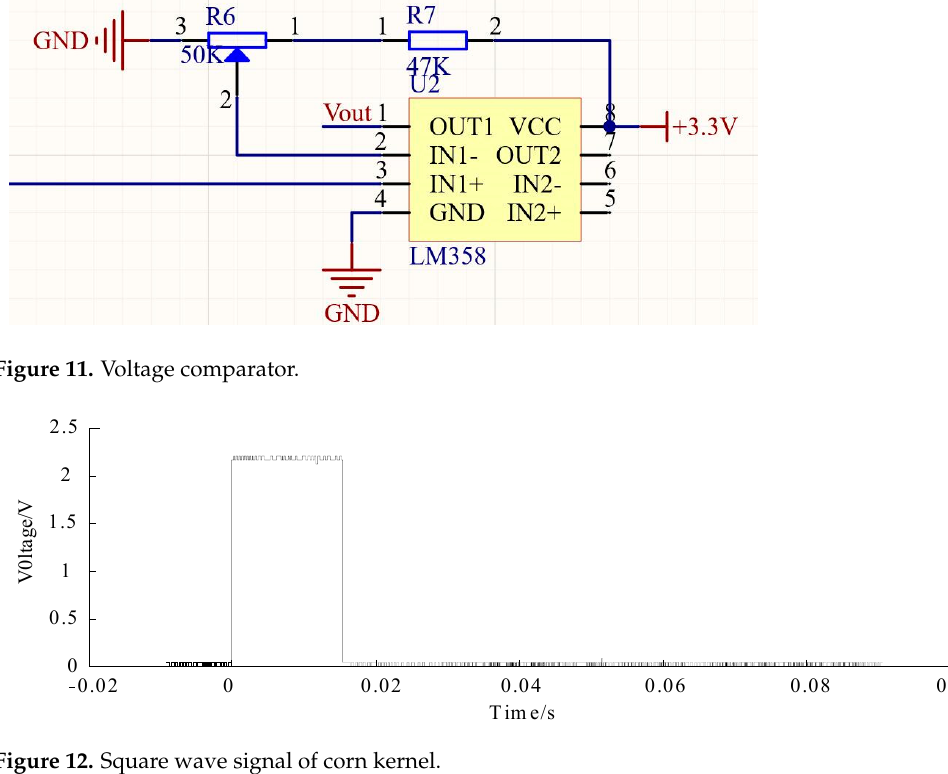
Figure 12. Square wave signal of corn kernel.